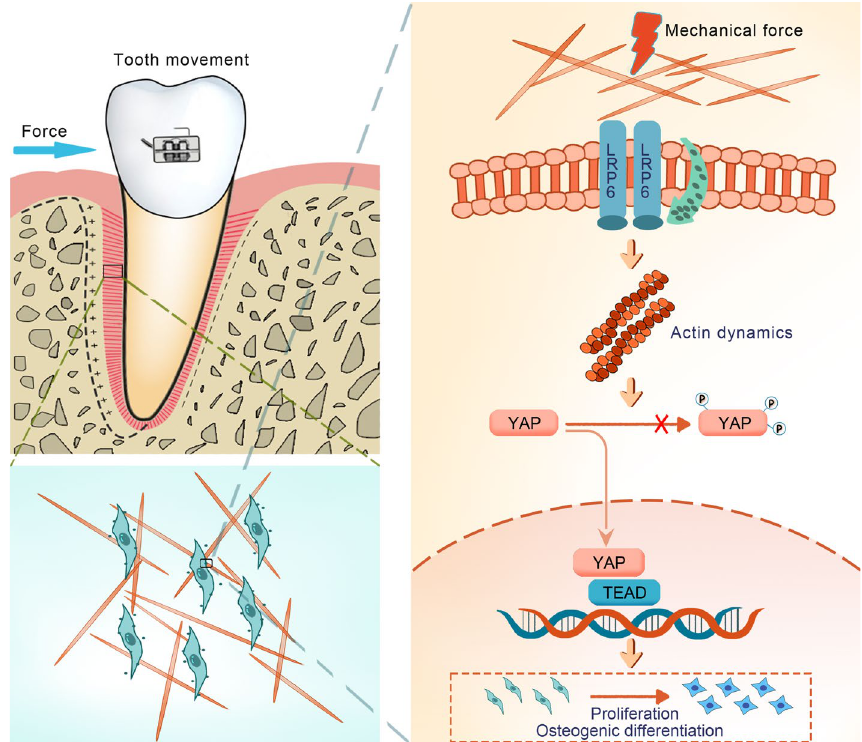
Fig. 6 Schematic diagram for the proposed mechanism. During alveolar bone remodeling that is initiated by orthodontic application, mechanical force enhances LRP6 membrane localization in PDLSCs. LRP6 mobilization then facilitates F-actin polymerization and rearrangement and further boosts YAP shuttling to the nucleus. Activated YAP subsequently promotes cell proliferation and osteogenic differentiation and ultimately leads to new bone